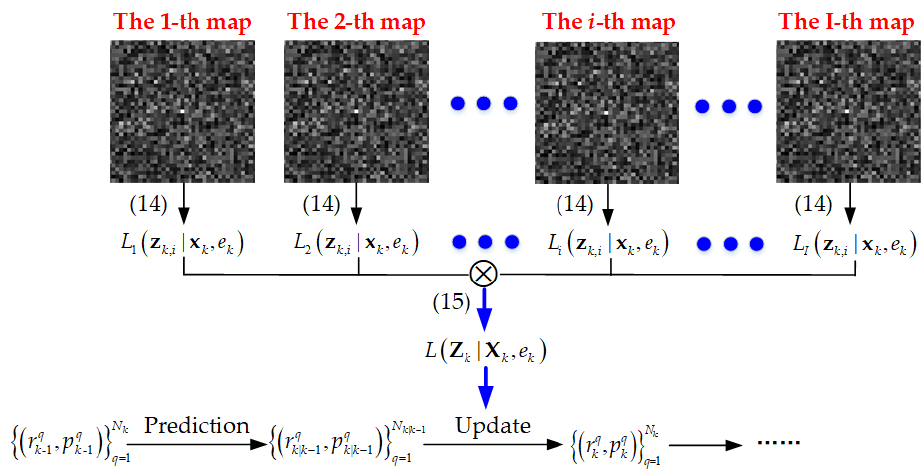
Figure 4. Propagation track table of the product multi-Bernoulli filter.